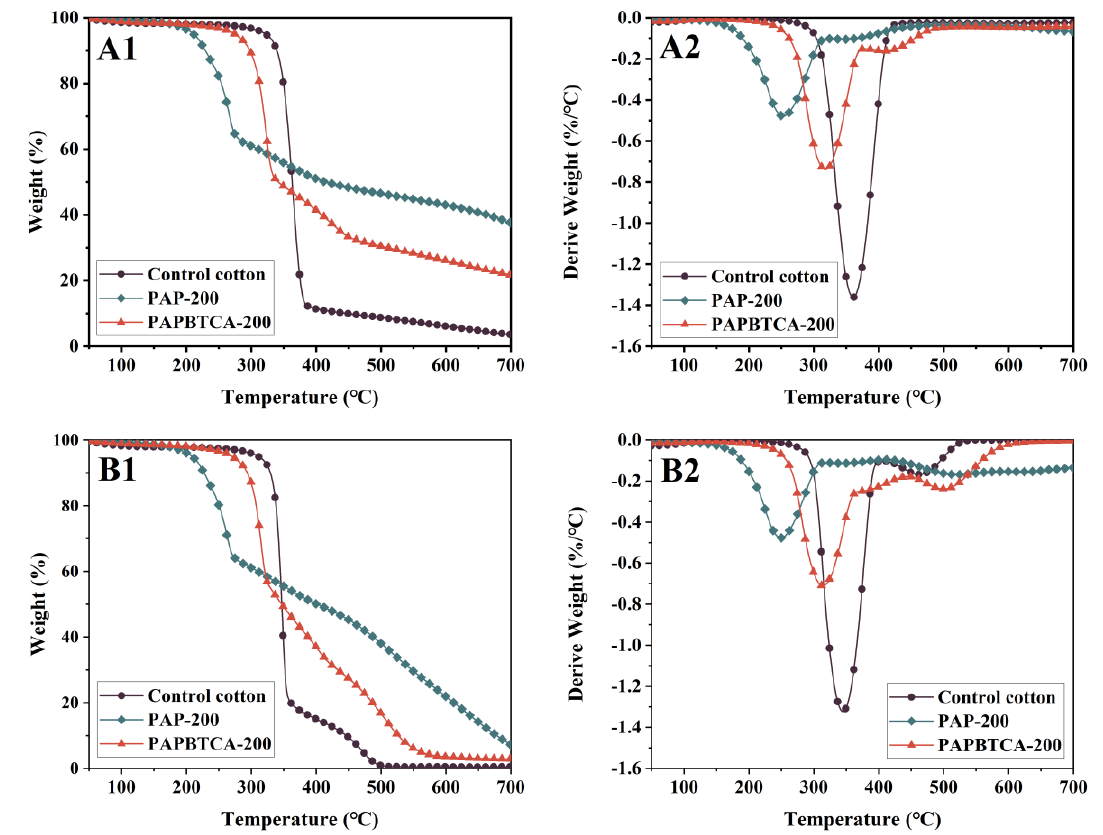
Figure 4. TG and DTG curves of the control, PAP-200, and PAPBTCA-200 in N 2 ( A1 , A2 ) and air ( B1 , B2 ). Table 2. Thermogravimetric analysis data of the control, PAP-200, and PAPBTCA-200 in N 2 and air.